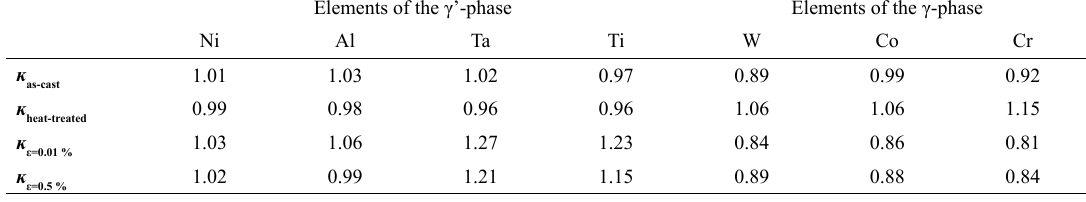
Table 3. Determined ĸ-values for selected elements contained in CMSX-4. Elements of the γ’-phase Elements of the γ-phase